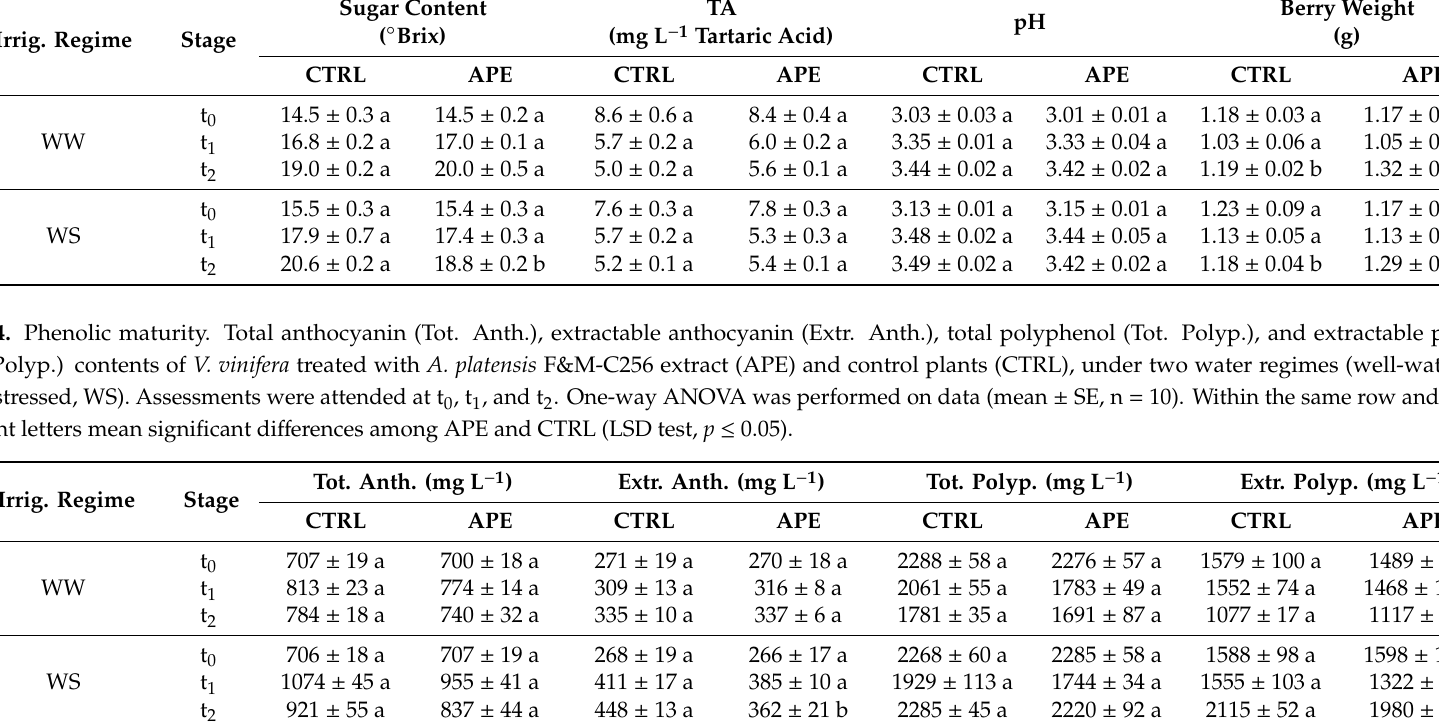
Table 3. Technological maturity. Sugar content, total acidity (TA), pH, and berry weight of V. vinifera treated with A. platensis F&M-C256 extract (APE) and control plants (CTRL), under two water regimes (well-watered, WW; water-stressed, WS). Assessments were attended at t 0 , t 1 and t 2 . One-way ANOVA was performed on data (mean ± SE, n = 10). Within the same row and parameter, di ff erent letters mean significant di ff erences among APE and CTRL (LSD test, p ≤ 0.05).